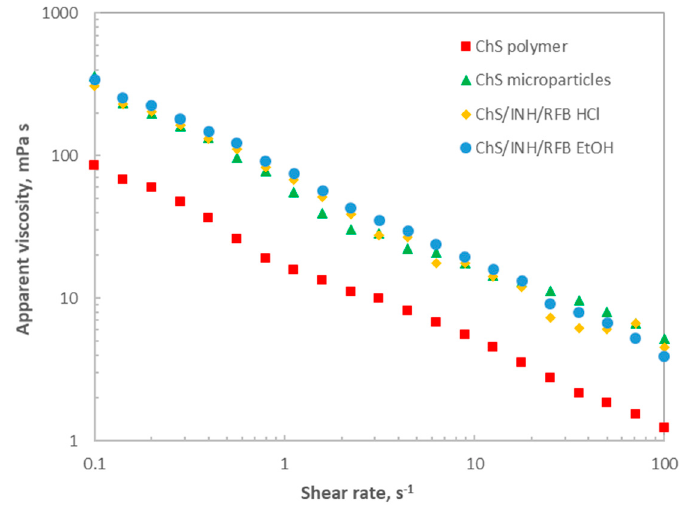
Figure 4. Steady shear flow curves for aqueous dispersions of chondroitin sulphate (ChS) polymer, ChS unloaded microparticles and ChS / INH / RFB microparticles produced with ethanol (EtOH) or HCl, at a polymer concentration of 10 g / L and 25 ºC.